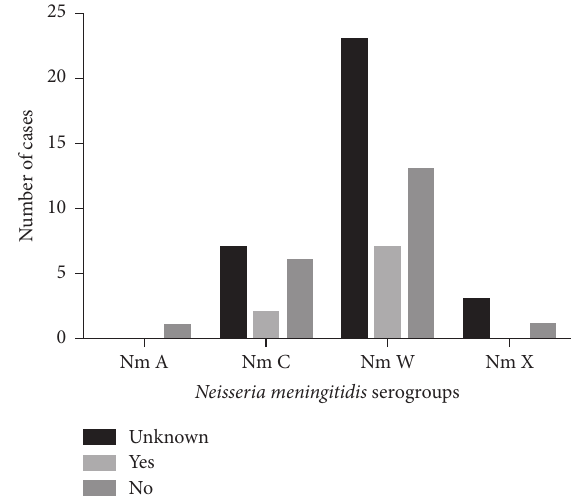
Figure 3: Frequency of the different serogroups of N. meningitidis according to the immunization status in the Republic of Benin from 2016 to